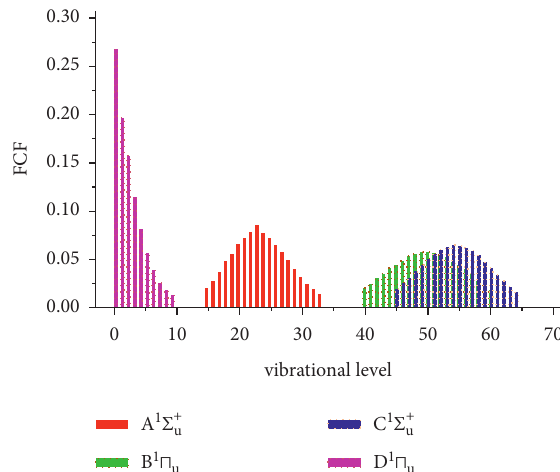
Figure 3: The Frank–Condon factors of transitions from the ground state to vibrational levels of excited